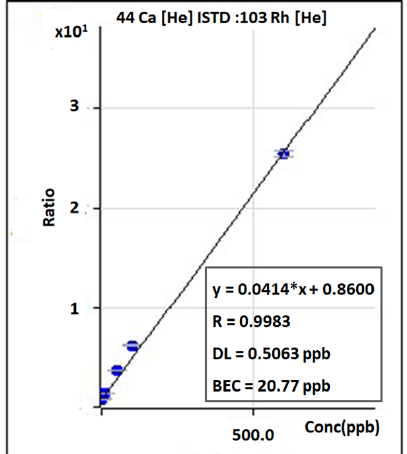
Figure 3. Example of a typical calibration standard curve ( 44 Ca in helium mode ([He]) with Rh a linear regression, R: Standard Deviation, DL: Detection Limits, BEC: Background Equivalent Concentration. Units of Ratio between the signal of 44 Ca and 103 Rh ( y -axis): counts per second (CPS).